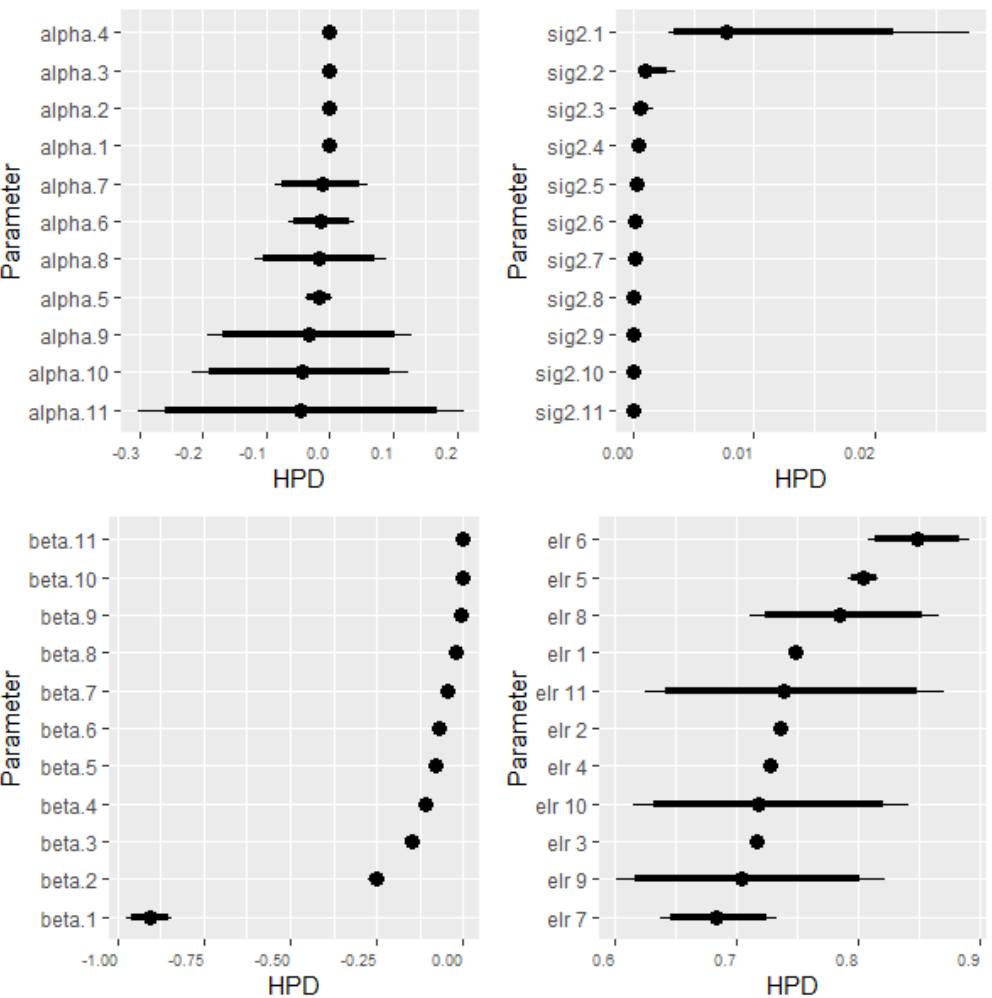
Figure 1. We show the caterpillar plots for the parameters of the Correlated Chain Ladder (CCL). The higher posterior density regions (HPD) give an immediate overview of the learning update for each parameter. The thick line represents the 90% HPD while the thinner one extends it to a 95% HPD (Indexes start from